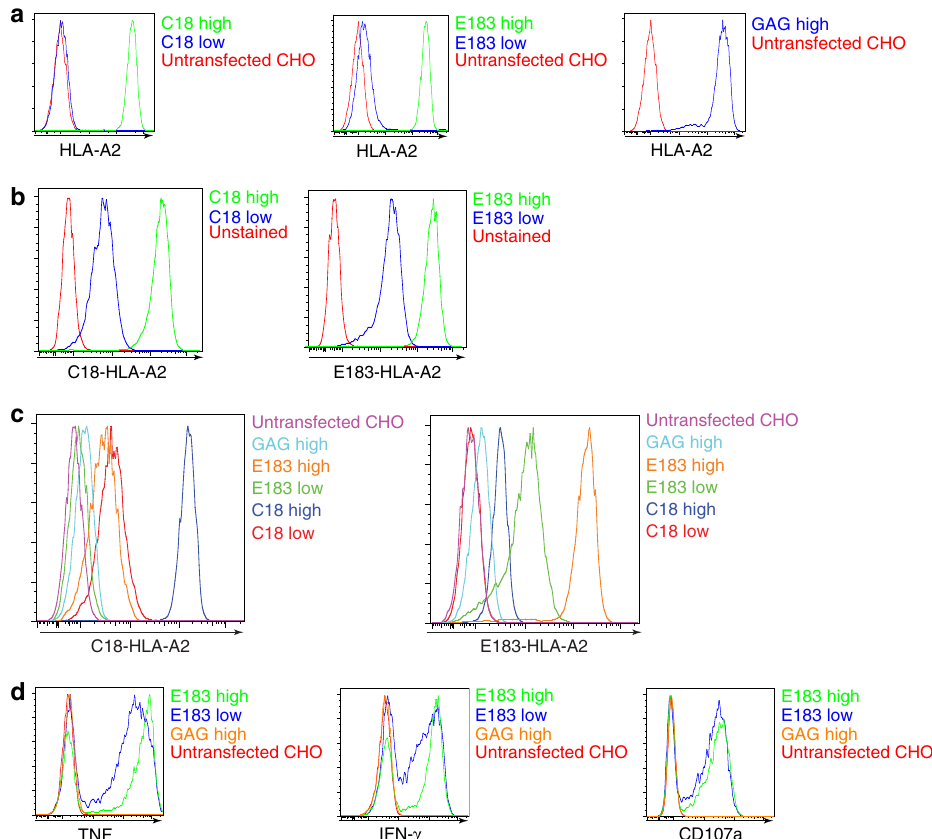
Fig. 1 Inducible expression of human single-chain (sc)-MHCI in T-REx CHO cells and their immunogenicity to human CTL. a anti-HLA-A2 staining of T-REx CHO clones expressing low amount or high amounts of (doxycycline-induced) human single-chain (sc)-MHCI. b TCR-like antibody anti-C18-HLA-A2 or anti-E183-HLA-A2 staining of T-REx CHO clones expressing low or high concentrations of C18/E183-HLA-A2 sc pMHC. c TCR-like antibody anti-C18-HLA- A2 or anti-E183-HLA-A2 staining of T-REx CHO clones expressing low or high C18/E183-HLA-A2 sc pMHC, high concentration of GAG-HLA-A2 sc pMHC, and unstransfected T-REx CHO cells. d Human E183 epitope-speci fi c CTL were cultured with the indicated T-REx CHO cells for 3 h and cytokine expression (TNF and IFN- γ ) and upregulation of the degranulation marker CD107a were assessed by fl ow cytometry. Data are representative of fi ve independent